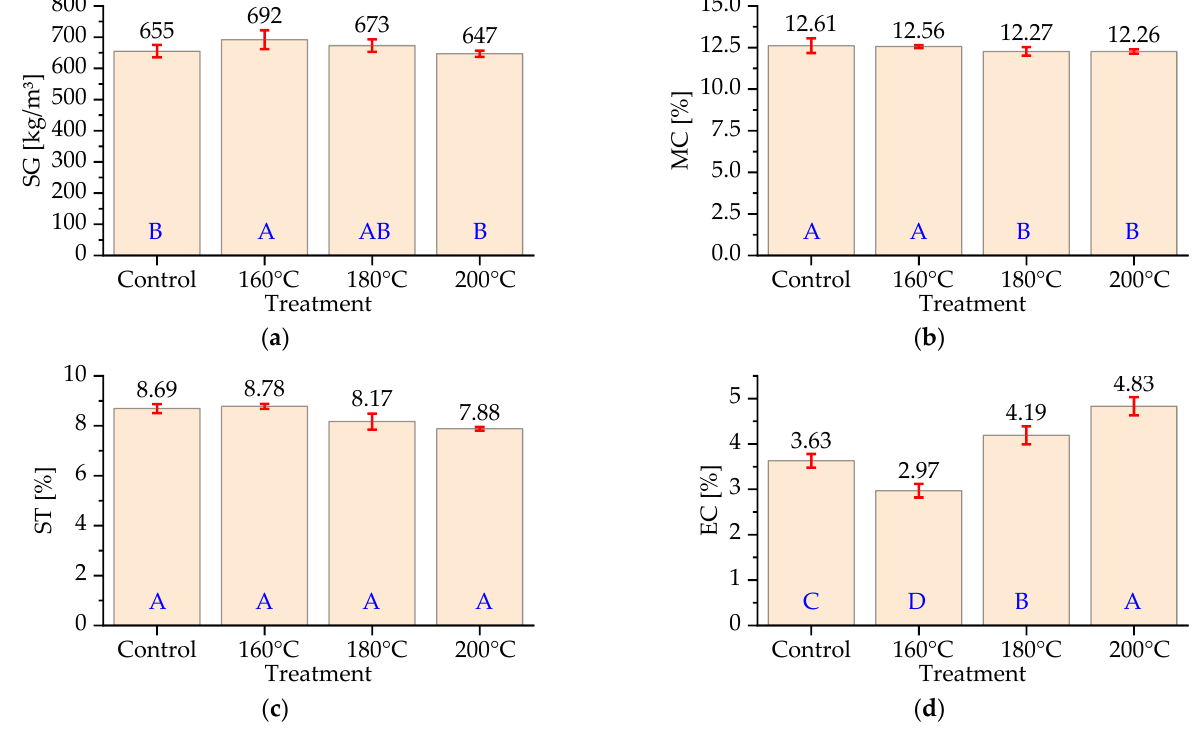
Figure 7. Physical properties of plywood produced with heat treated veneers: specific gravity ( a ), moisture content ( b ), swelling in thickness ( c ) and total extractive content ( d ). Same letters in columns implies that there was no statistical difference with 95% of confidence.